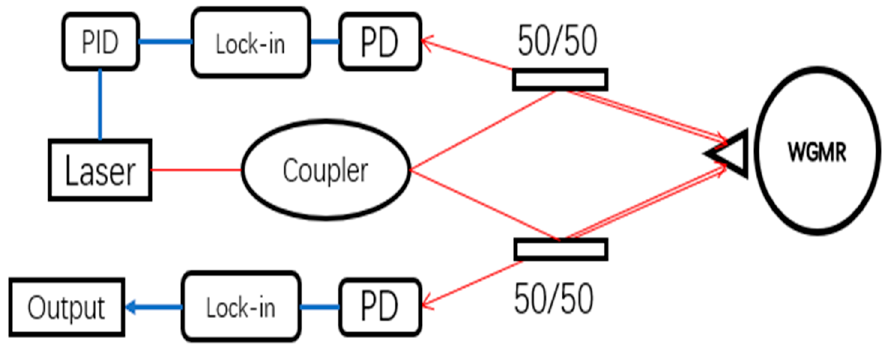
Figure 3. Schematic diagram of a whispering gallery mode resonator (WGMR)